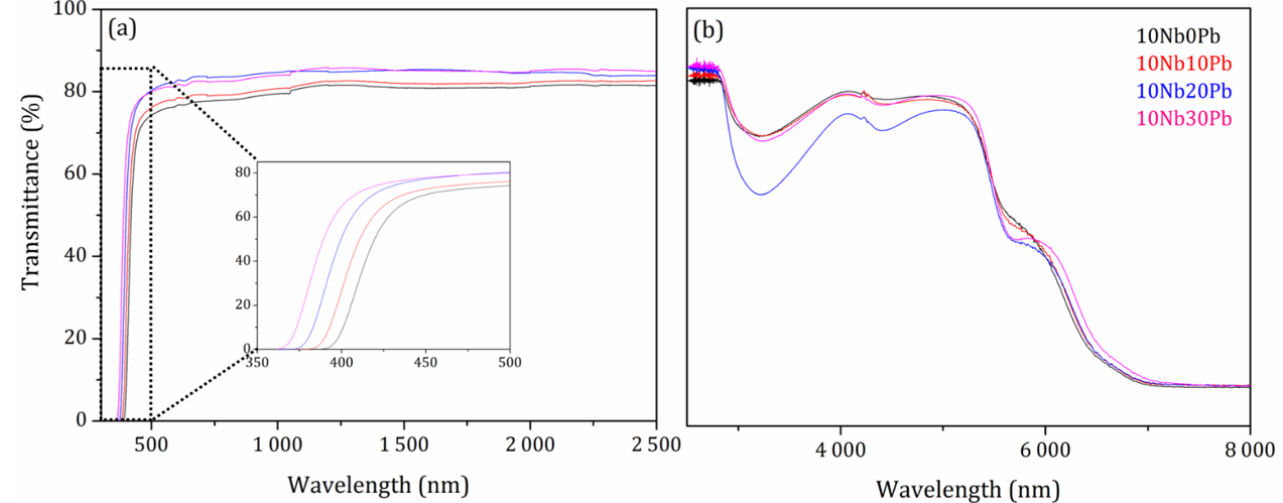
Figure 5. Optical window of glass samples in the ( a ) UV-visible-near infrared and ( b ) middle infrared ranges between 350 and 8000 nm.